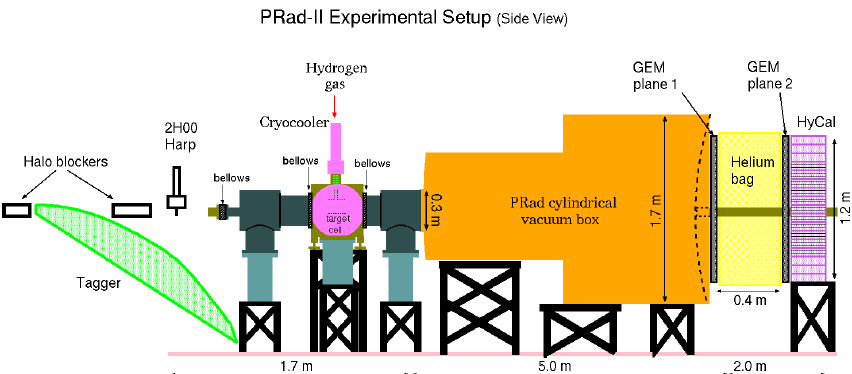
Figure 10. The experimental apparatus of the PRad-II experiment. Figure credit: A. Gasparian et al. [123].